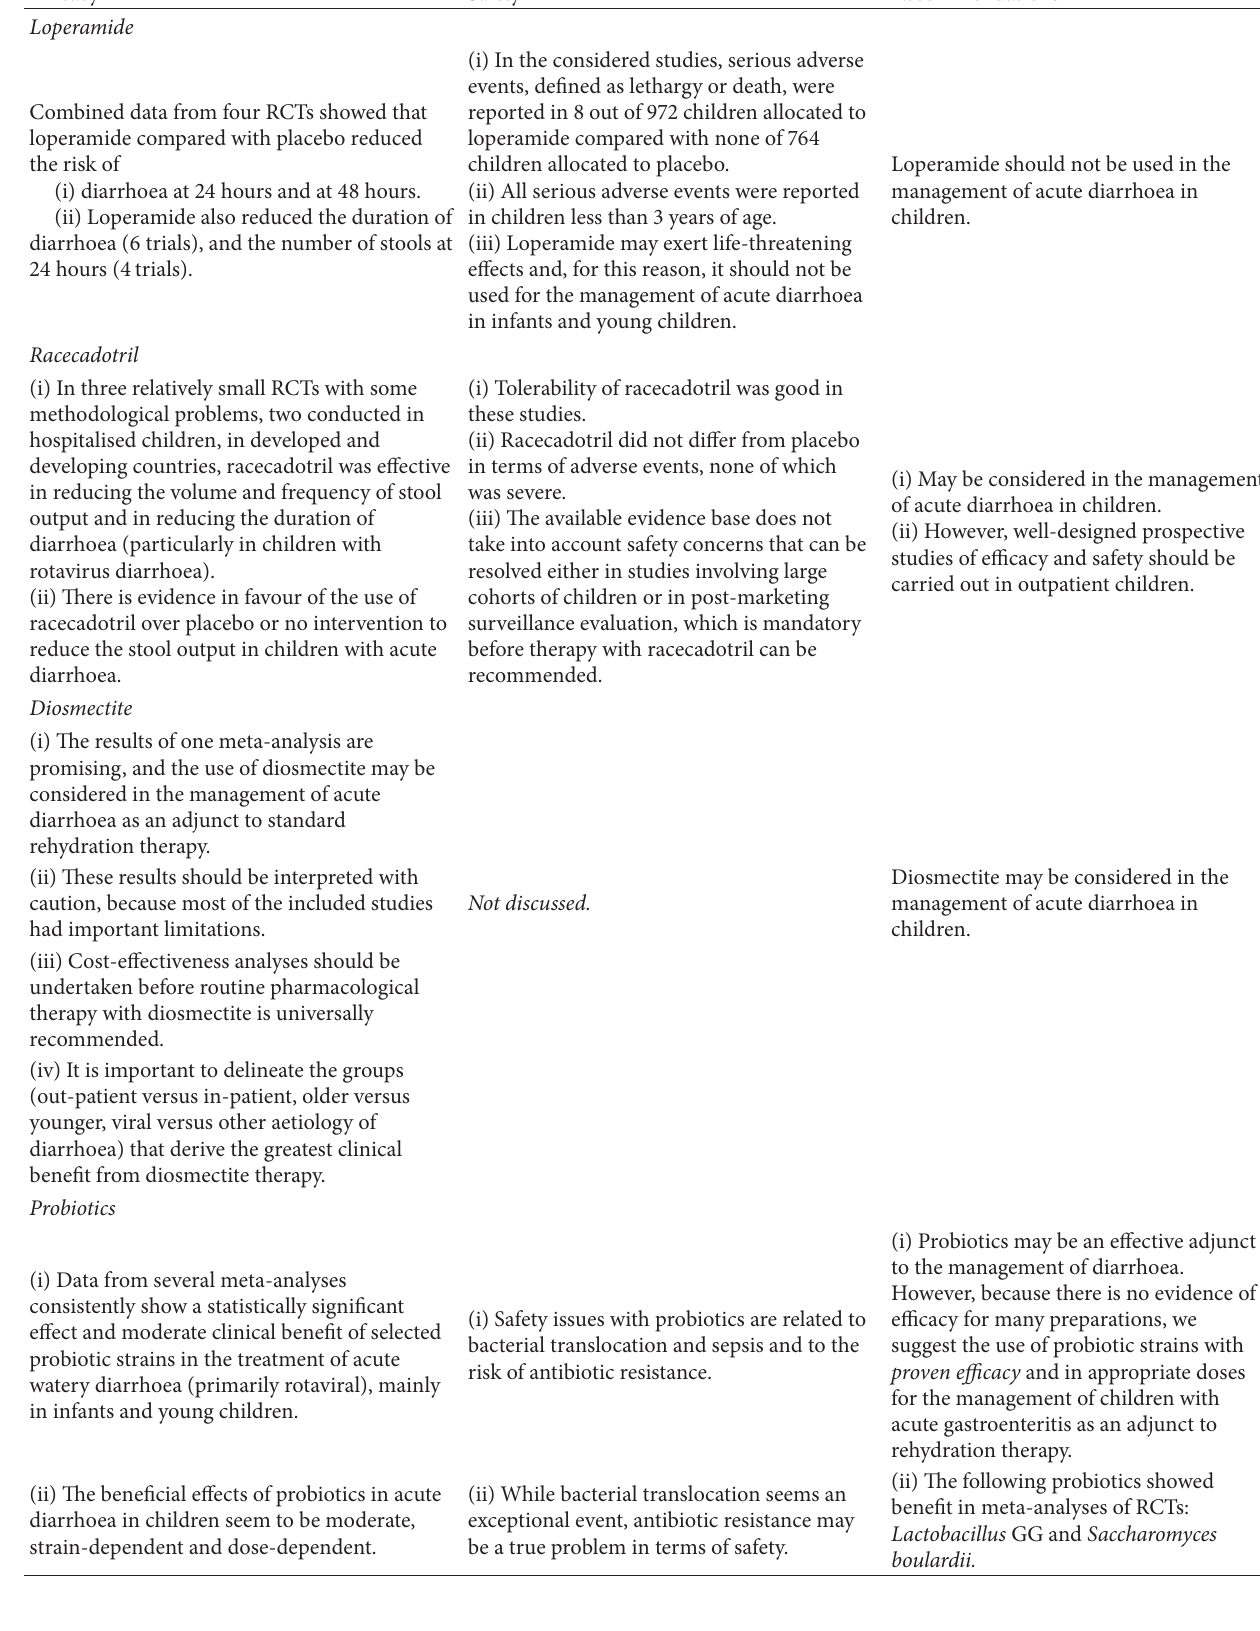
Table 3: Overview of benefits and risks of anti-diarrhoeal drugs based on ESPGHAN/ESPID guidelines [39].